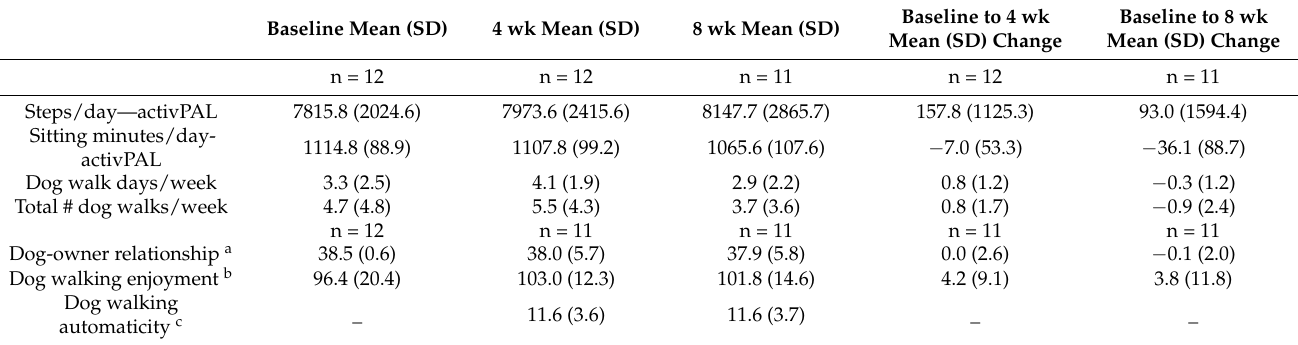
Table 2. Physical activity, dog walking, and psychosocial outcomes.